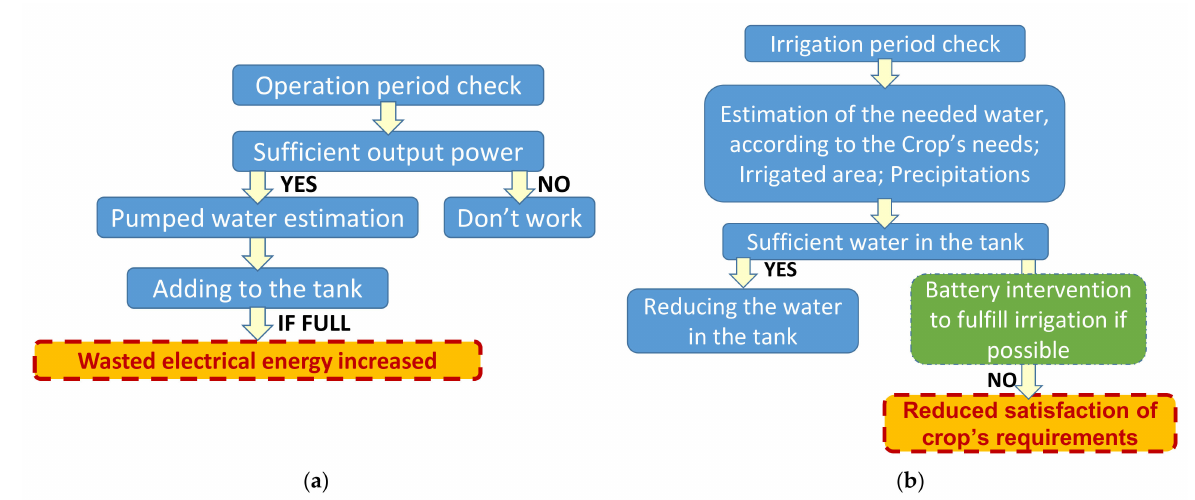
Figure 5. Simplified flowcharts of simulated processes during the year: ( a ) pumping; ( b )